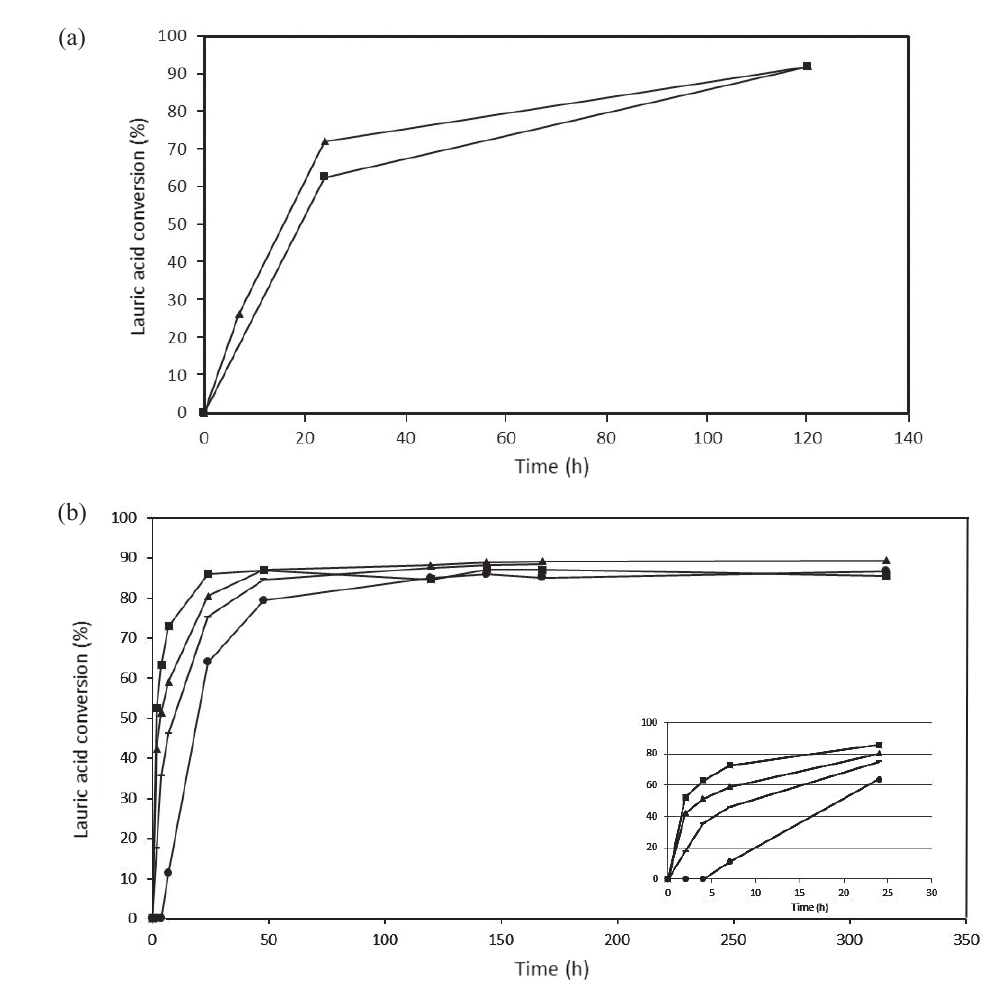
Fig. 2 – (a) Conversion of lauric acid at 1:1 (▲) and 2:1 PG-10 and LA ratio (■) (b) conversion of lauric acid at 1:1 PG-10 and LA ratio (●) and addition of 5 (-), 10 (▲) and 25 (■) wt% PG-10 laurate. LA = lauric acid; PG =